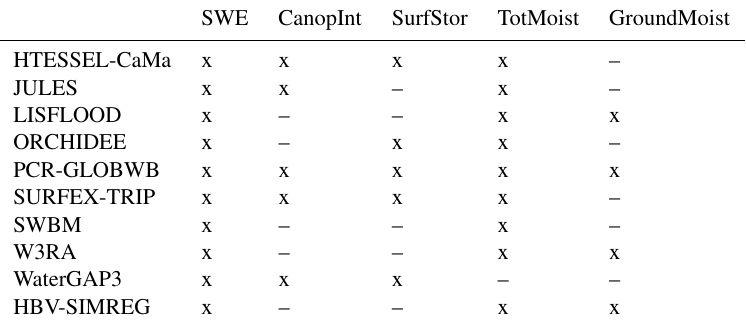
Figure 4. BIOMES used in calculating regional averages. These are: AUST (Australia), EQAS (equatorial Asia), SEAS (Southeast Asia), CEAS (central Asia), BOAS (boreal Asia), SHAF (Southern Hemisphere Africa), NHAF (Northern Hemisphere Africa), MIDE (Middle East), EURO (Europa), SHSA (Southern Hemisphere South America), NHSA (Northern Hemisphere South America), CEAM (Central America), TENA (temperate North America) and BONA (boreal North America). Table 4. Components used in total water storage estimation for each model. The definition of the variables can be found in Table 3.